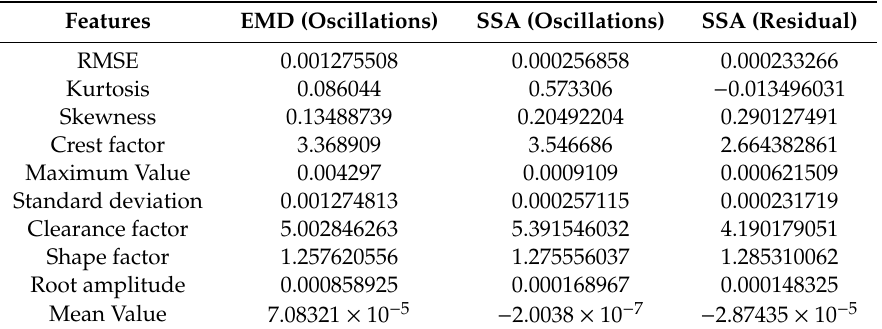
Table 2. Features time domain of the error indexes of reconstructed oscillations via the empirical mode decomposition (EMD) technique and the singular spectrum analysis (SSA) technique and the error indexes of the rebuilt residue via SSA technique. (Unit: ◦